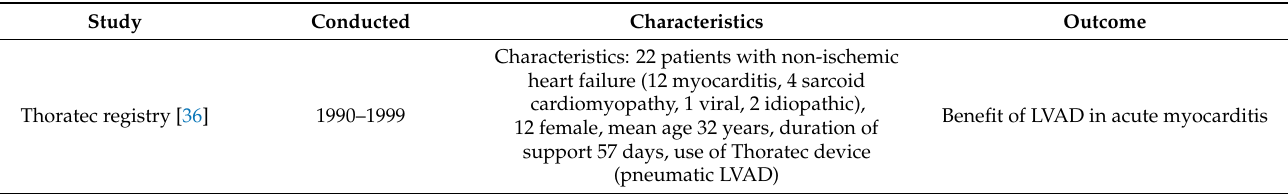
Table 1. Myocardial recovery studies in patients with